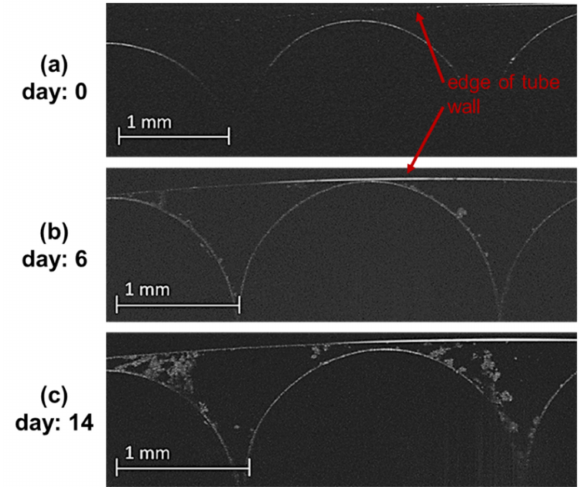
Figure 3. OCT B-Scans acquired from a previous experiment under permanently saturated conditions. ( a ) Three glass spheres before inoculation. ( b ) After 6 days, biofilm could be found on the particle surface in the form of small colonies. ( c ) Biofilm covered the voids between the particles and the column wall after 14 days. A biofilm as distinct as in ( c ) was accessible by means of